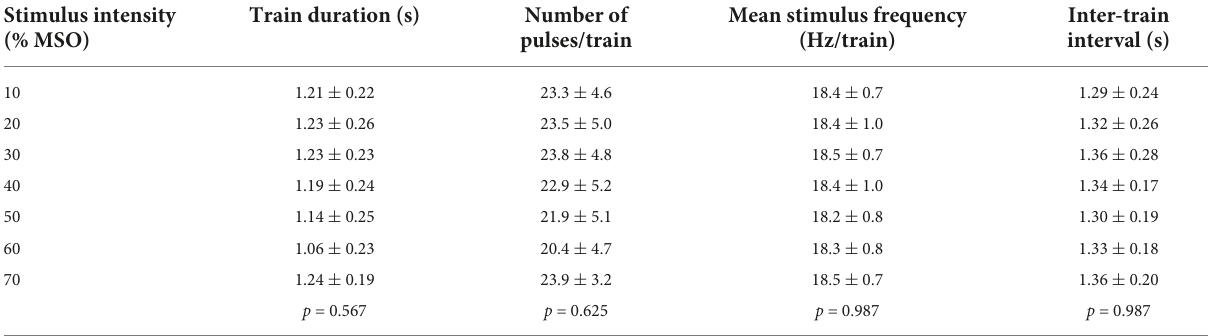
TABLE 2 Temporal profiles of stimulus triggers in Experiment